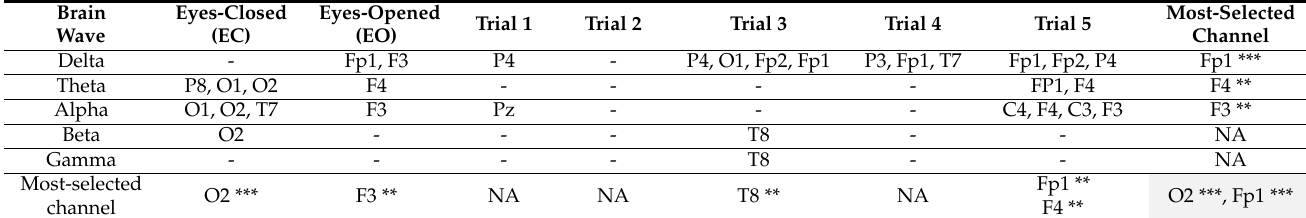
Table 4. The significant channels obtained from paired t -test analysis of brain activities between students in the two conditions (pre- and post-BMI) that could serve as potential EEG channels to identify/indicate BMI